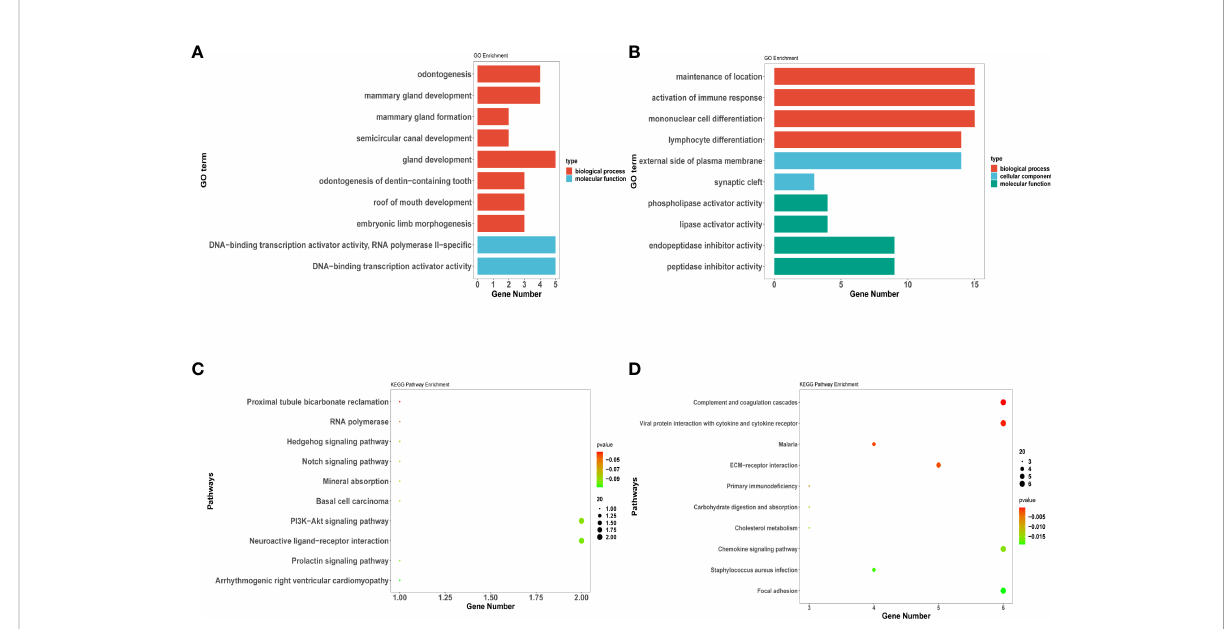
FIGURE 7 DEGs related to invasiveness analysis for Gene Ontology (GO) and Kyoto Encyclopedia of Genes and Genomes (KEGG) enrichment. (A – D) represent the enrichment analysis results of DEG genes involved in invasiveness. (A) (C) indicate the upregulated DEGs enriched in GO terms and KEGG pathway; (B) (D) indicate the downregulated DEGs enriched in GO terms and KEGG pathway. The main results of each term are shown, where the color indicates the signi fi cant degree of enrichment and the size indicates the number of genes enriched for each